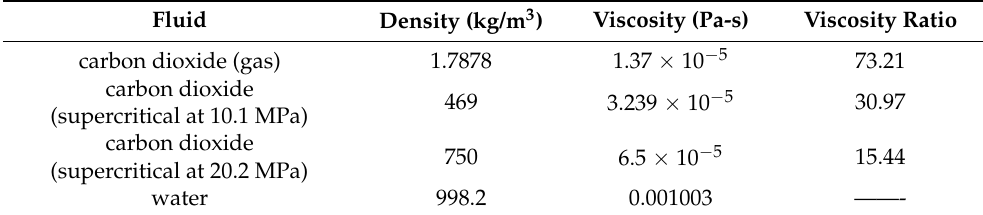
Table 1. Material properties of fluids used in simulations.